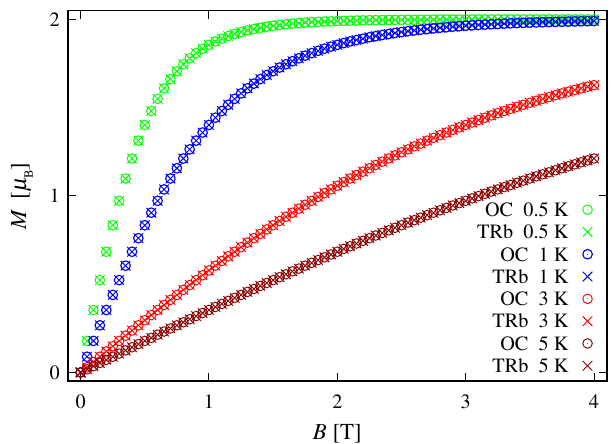
Figure 5. The magnetization of the octahedral (OC) and trigonal bipyramidal (TRb) complexes for different temperatures. The results are obtained for values of the model parameters provided at the end of Section 2.1.